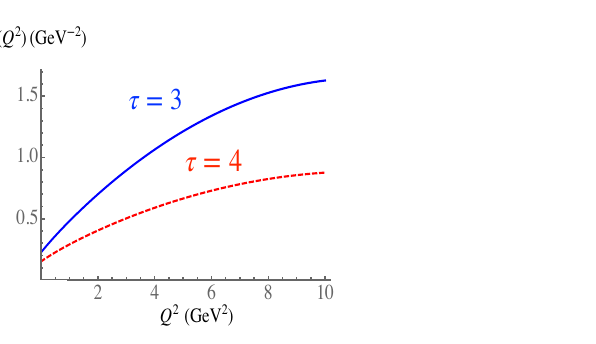
Figure 2. The function b 2 ( Q 2 ) . The numbers refer to the value of τ , the number of constituents in the Fock state. See text for